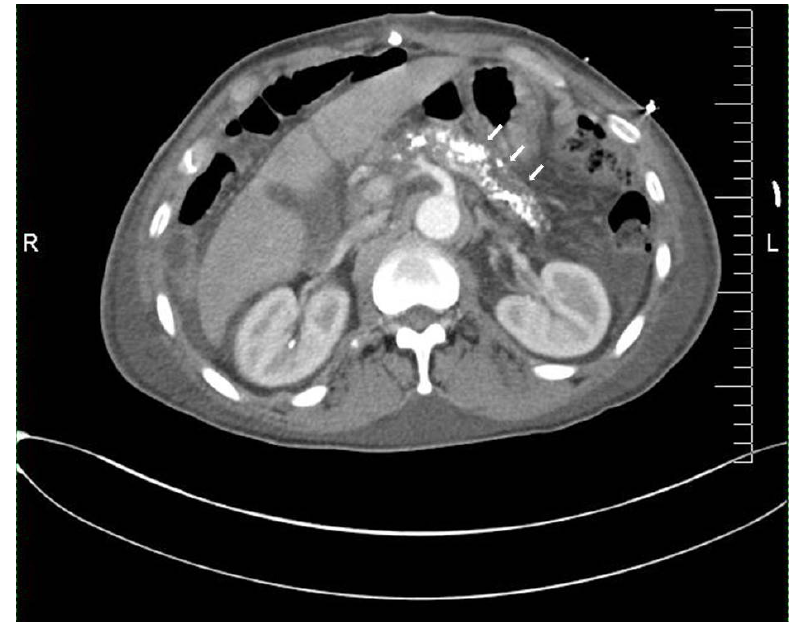
Figure 2. CT Abdomen. Calcifications within the pancreas are shown by